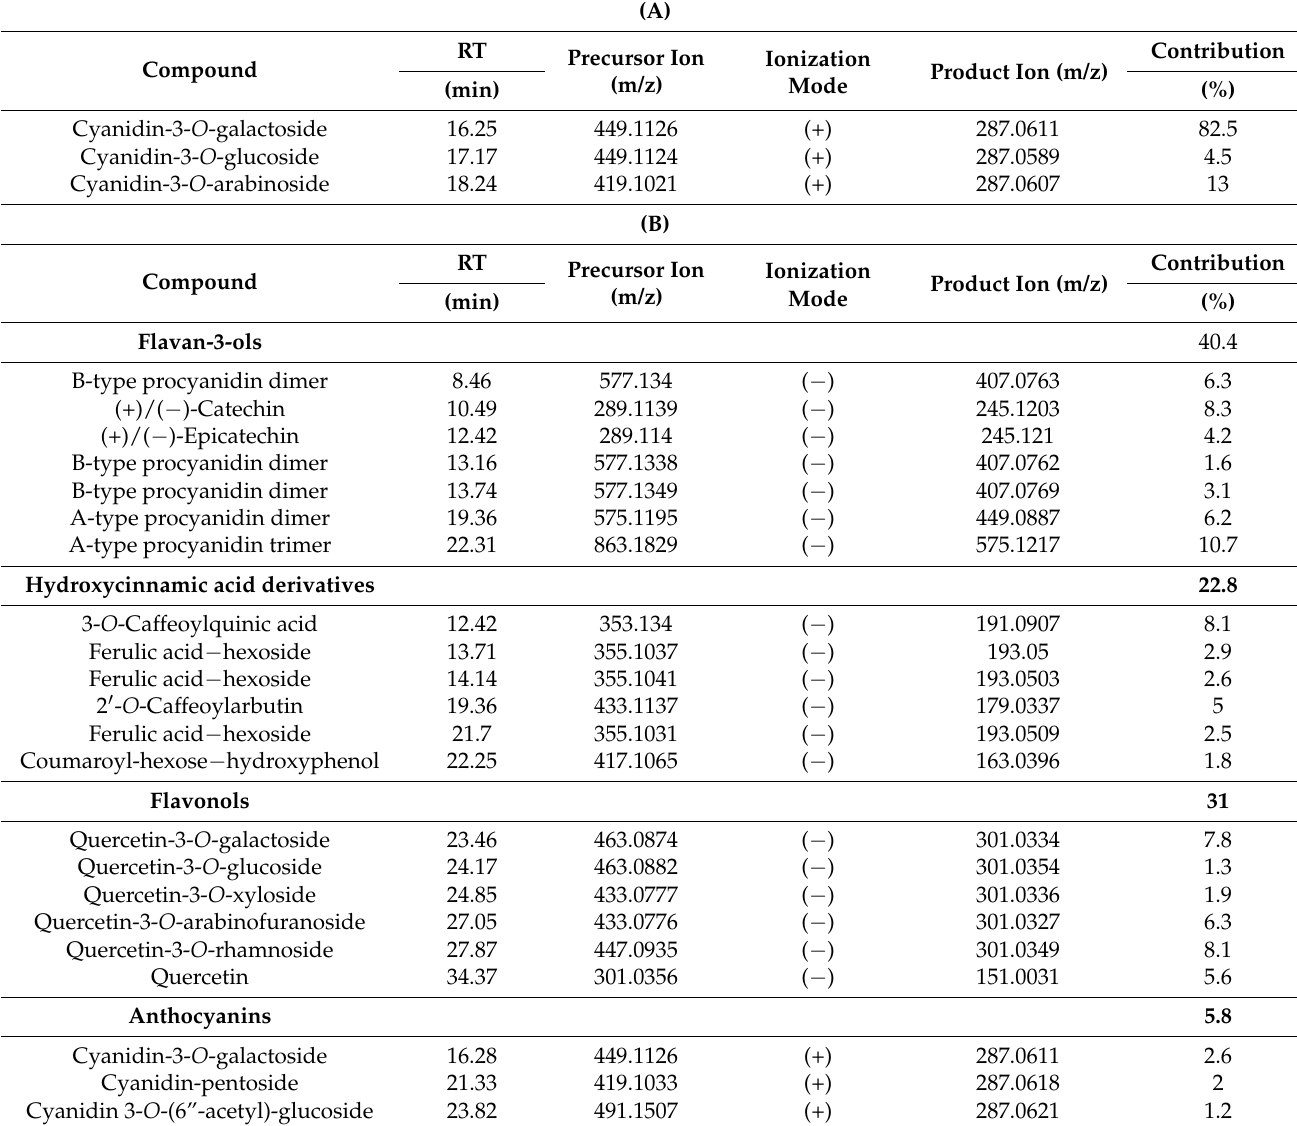
Table 1. Compounds identified in anthocyanin (ACN) fraction ( A ) and non-anthocyanin polyphenol (PP) fraction ( B ) obtained from lingonberry